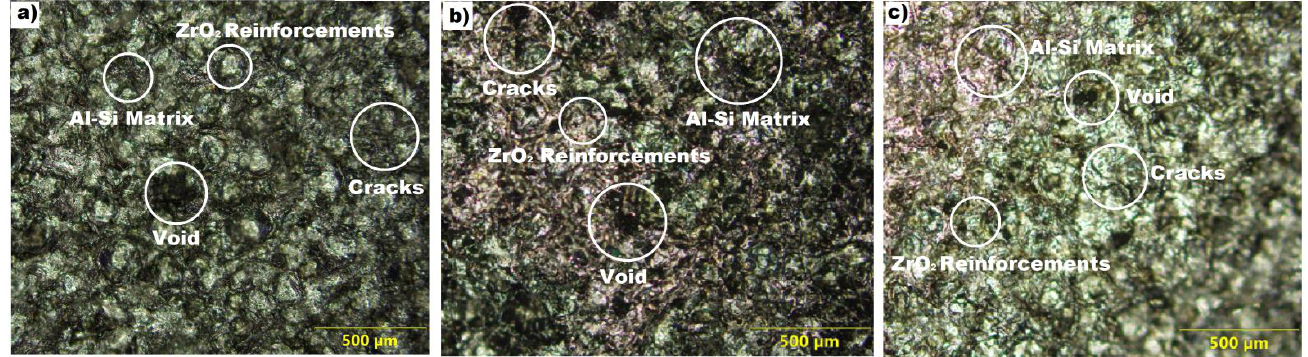
Figure 24. SEM images of fracture surface of ( a ) Si-Al-ZrO 2 (5 wt.%); ( b ) Si-Al-ZrO 2 (10 wt.%); ( c ) Si-Al-ZrO 2 (15 wt.%) for 13 wt.% Si (surface perpendicular to the direction of loading).